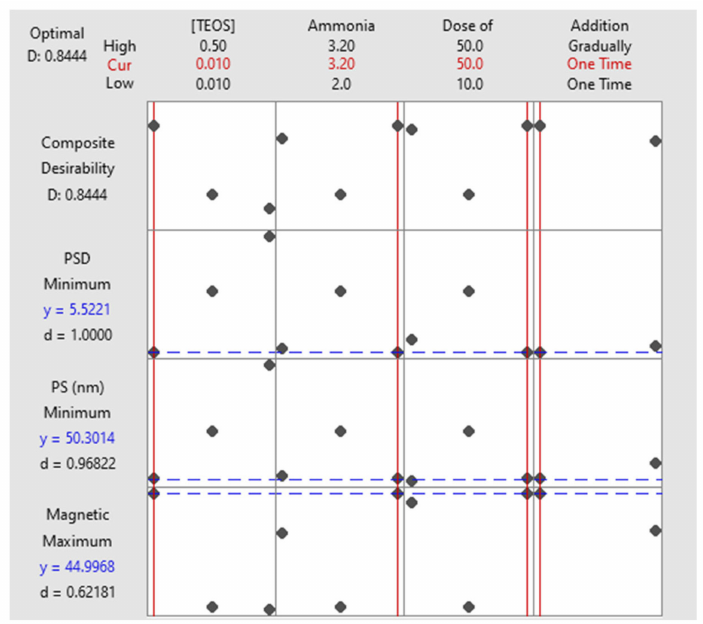
Figure 5. Optimization plot. The horizontal lines signify the present responses (highest magnetic properties, lowest PS, and particle size distribution (PSD)) while the upright lines are the optimal settings for each variable.